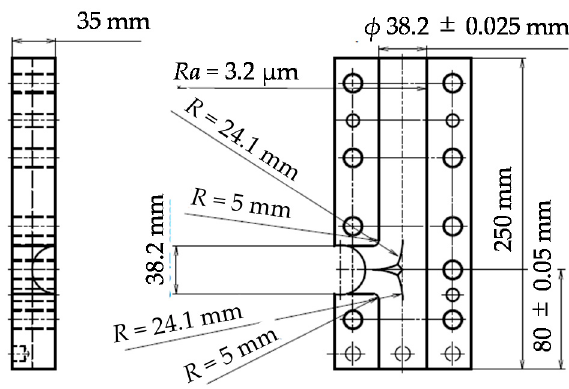
Figure 4. Dimensions of separate die (container).